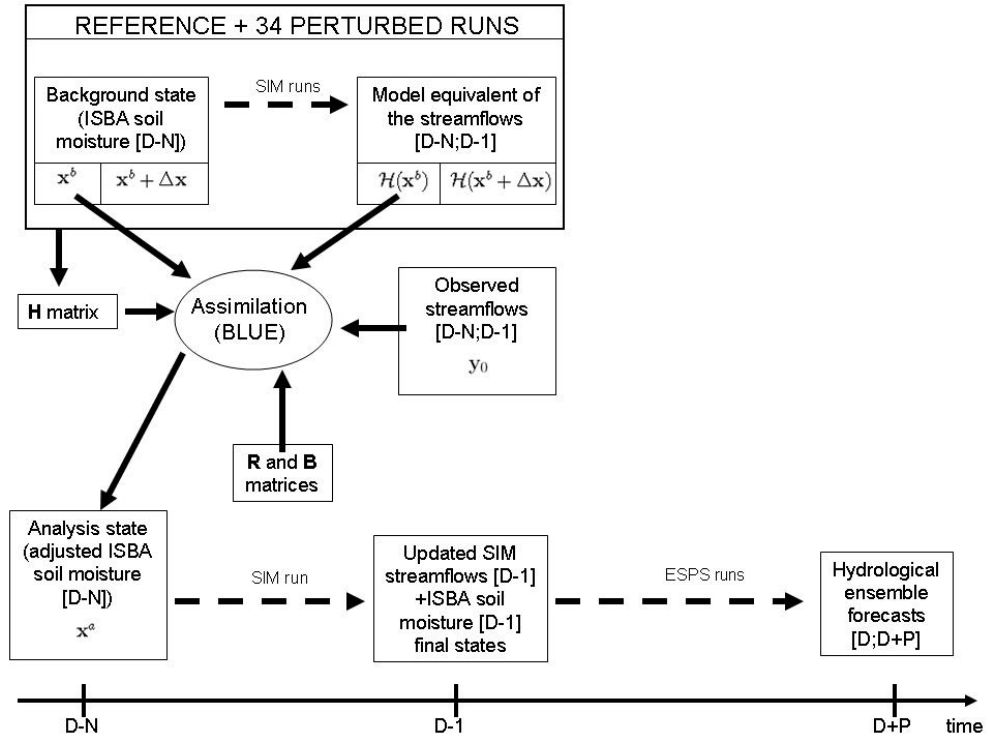
Fig. 2. Principle of the assimilation process for SIM for an assimilation over a N -day time window, initializing an ensemble streamflow forecasts lasting P days.